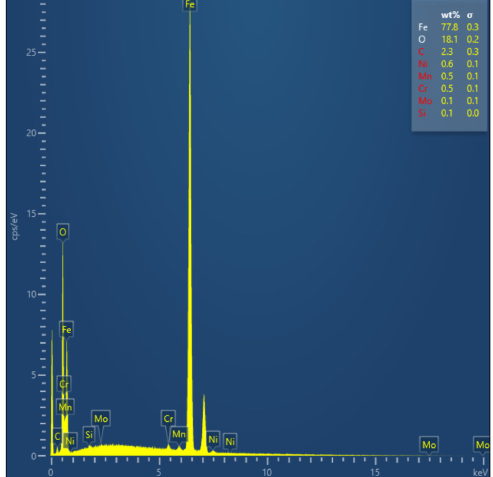
Figure 26. The EDS analysis results of area A in Figure 25.